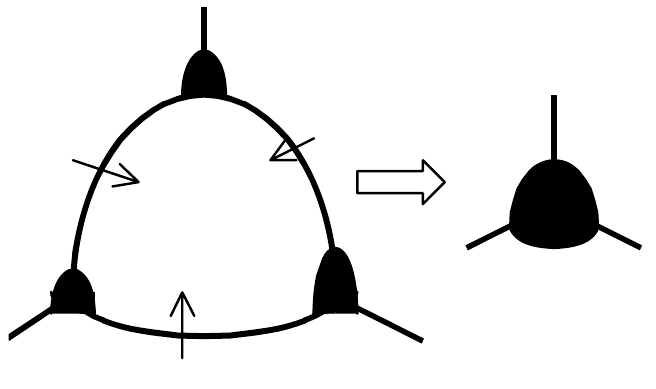
Figure 1. Pore migration with boundaries and resulting pore growth during normal grain